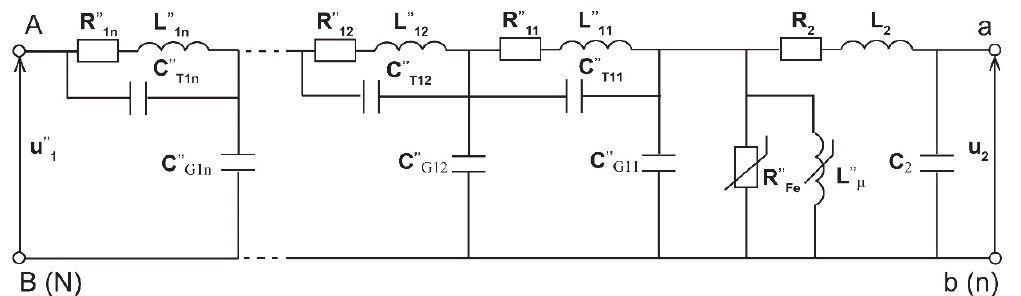
Figure 9. The equivalent circuit of the inductive VT for transformation of distorted voltage [3].